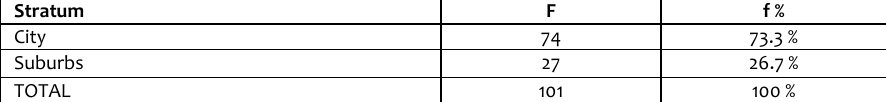
Table 1: Numbers (f) and structural percentages (f %) of students according to stratum.